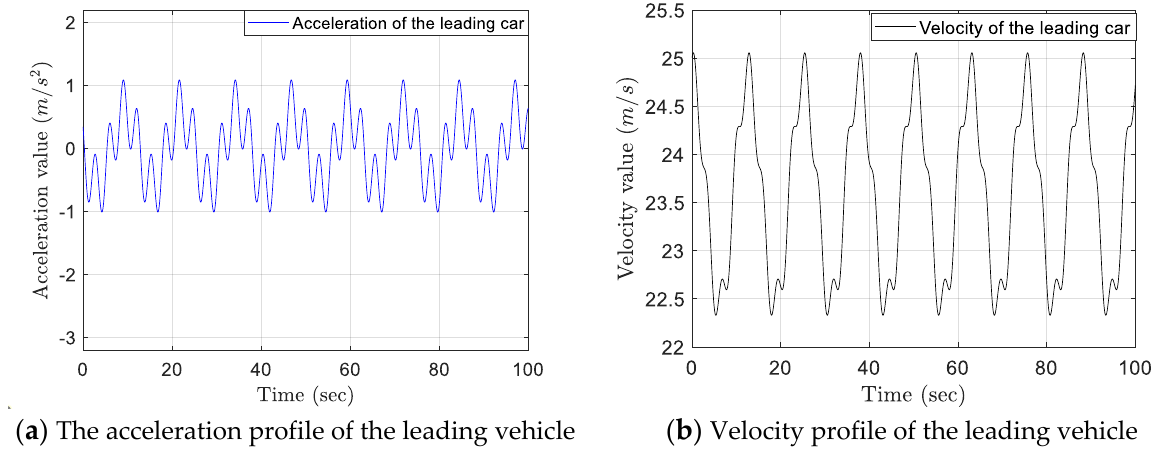
Figure 6. Acceleration and velocity profile of the leading vehicle.